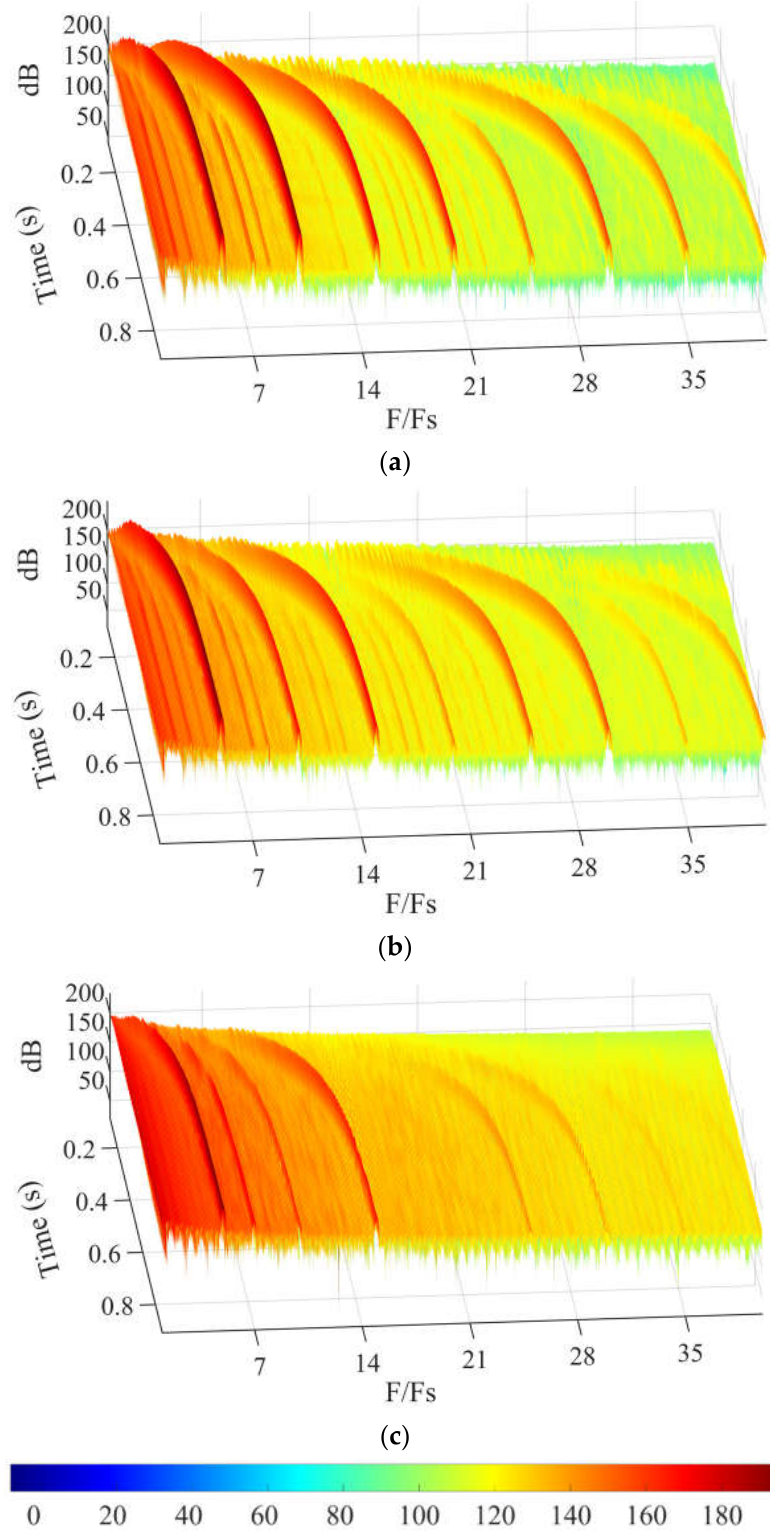
Figure 20. Time–frequency characteristics of pressure at the diffuser vane: ( a ) G1, ( b ) G2, and ( c ) G3.